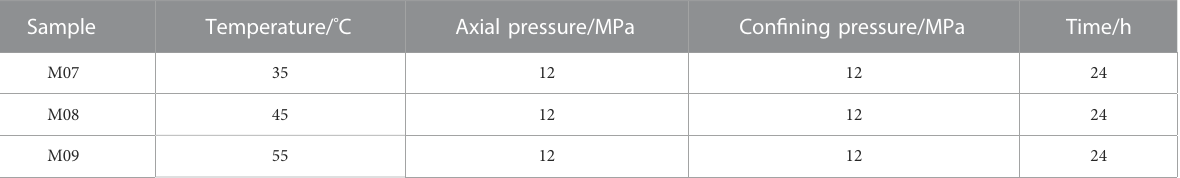
TABLE 5 Permeability enhancement experiment program.